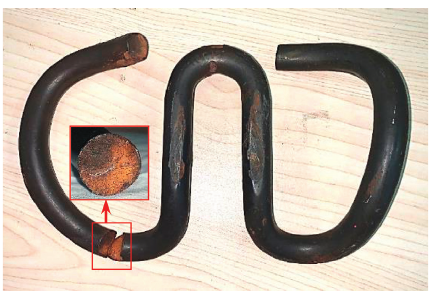
Figure 12: The actual fracture plane of a fastening